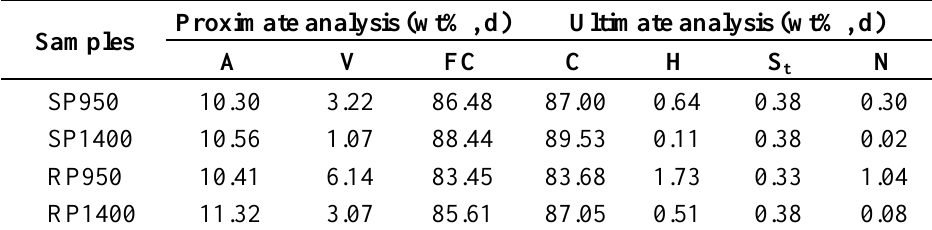
Table 4. Proximate and ultimate analysis of slow and rapid heating chars. Proximate analysis (wt%, d) Ultimate analysis (wt%, Samples